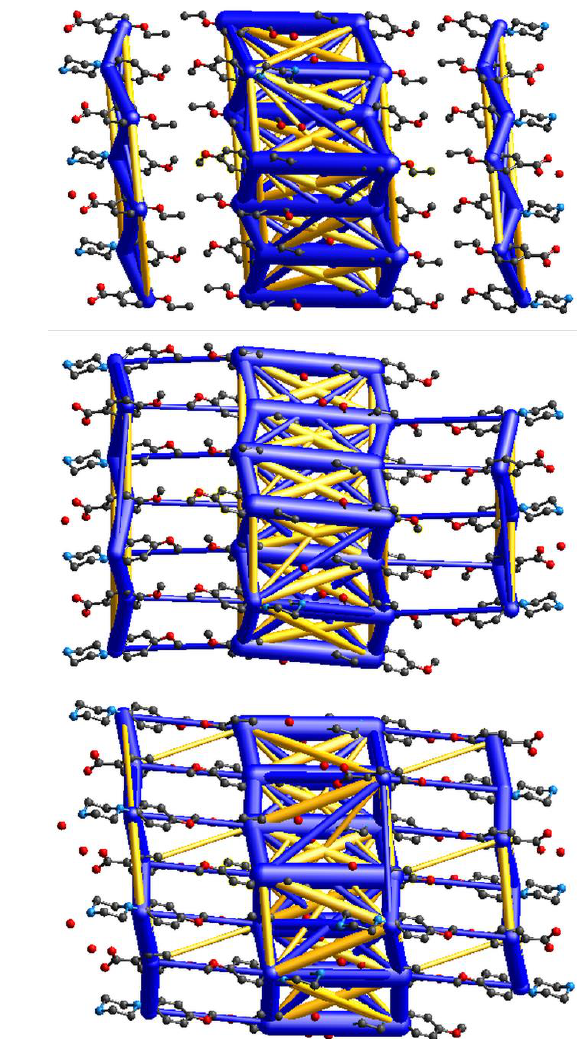
Figure 8. Diagrams of the total energy frameworks for 10 Å cluster of ( a ) (I), ( b ) (II), and ( c ) (III), respectively; drawn along the crystallographic a axis. All diagrams use the same energy tube scale factor of 20 and the energy threshold of 100 kJ mol −1 . The yellow cylinders represent destabilizing interactions.